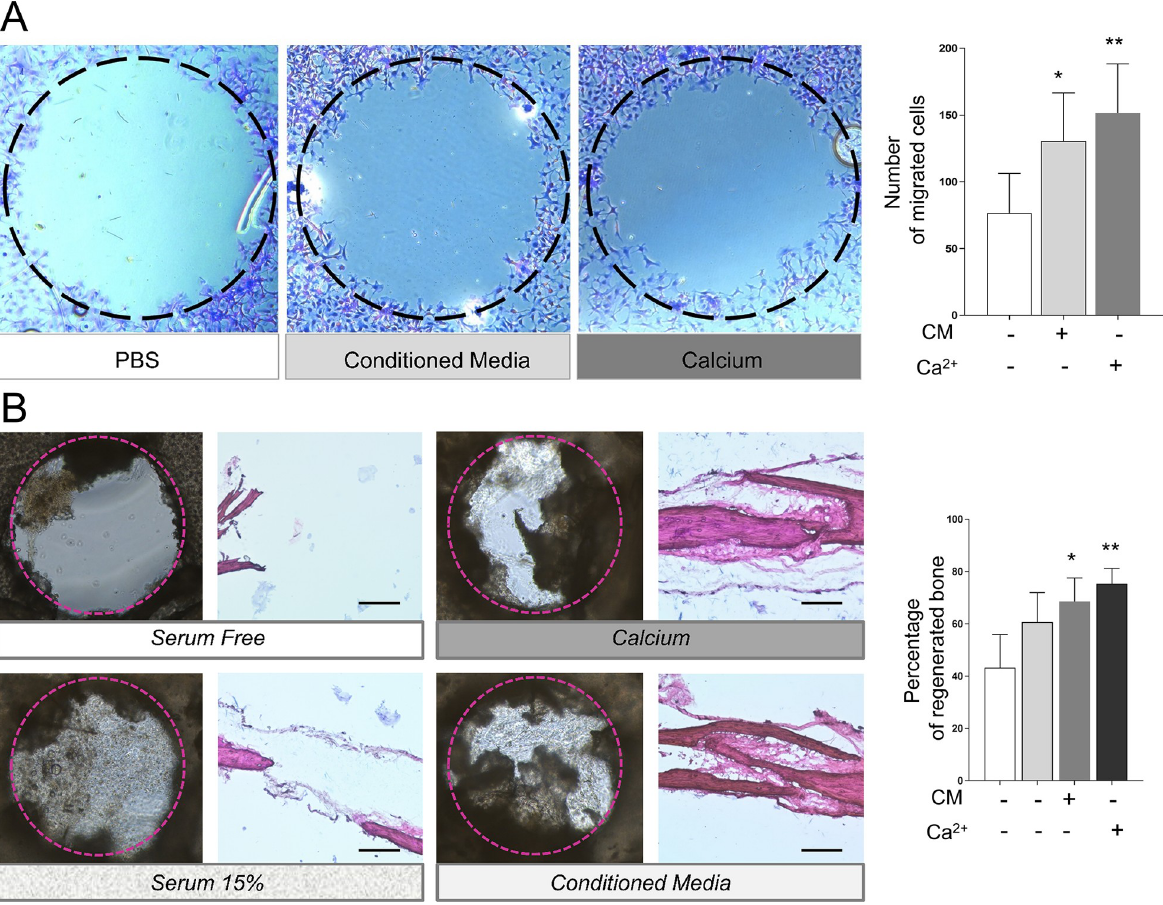
Fig 1. The effect of calcium or conditioned media on migration was evaluated by an agarose spot assay. (A) Three spots were plated on the same dish, one containing PBS, 10 mM CaSO 4 or conditioned media. Primary calvarial cell migration under each agarose spot was evaluated and quantified using ImageJ software. The experiment was repeated five times. (B) Calvaria were divided into two halves and a full thickness defect of 0.8 mm of diameter was created. Halves were placed individually in a 24-well plate serum free media (negative control), 15% FBS, 2.5 mM of CaSO 4 in 15% FBS media or conditioned media (n = 10). After two weeks, calvaria were fixed, images taken, and then prepared for histological evaluation. The percentage of regenerated bone was quantified by ImageJ. Representative images of each group are displayed. 20X scale = 400 μ m. Differences are considered significant at p <